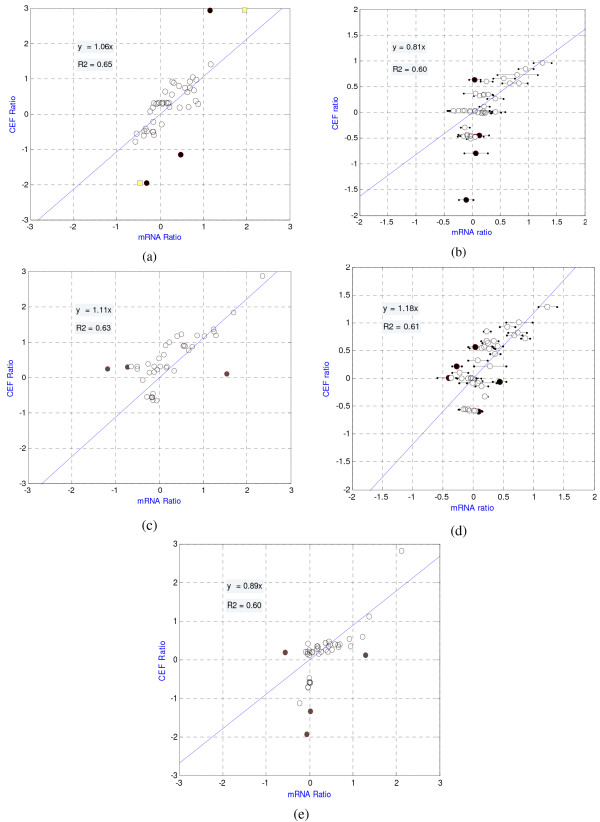
Comparison of the model-based and experimental data-based logarithmic ratios for carbon shifts. The filled circles are the omitted points to reach regression coefficient R2 0.60. (a) shift from glucose to ethanol for batch cultures under respiro-fermentative conditions (data from [20]). Filled squares belong to ratios for pfk12 and fbp1 from [21]. (b) shift from glucose to ethanol for chemostat cultures under respiratory conditions (data from [3]). (c) shift from glucose to acetate for batch cultures under respiro-fermentative conditions (data from [25]). (d) shift from glucose to acetate for chemostat cultures under respiratory conditions (data from [3]). (e) shift from glucose to lactate for batch cultures under respiro-fermentative conditions data from [30]. For experiments with replicate data (b and d), the horizontal lines on the circles show 95% confidence intervals.